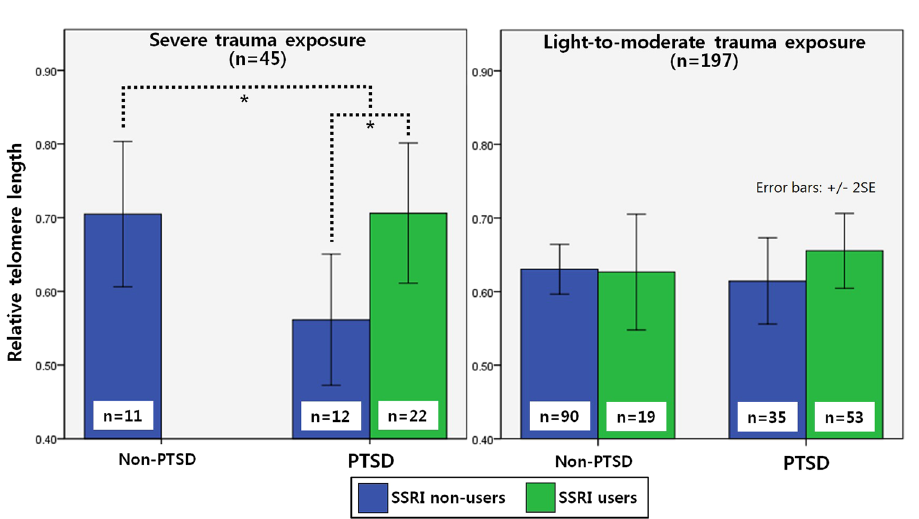
Figure 1. Comparisons of relative telomere length in PTSD and non-PTSD groups of combat veterans according to SSRI use and trauma exposure